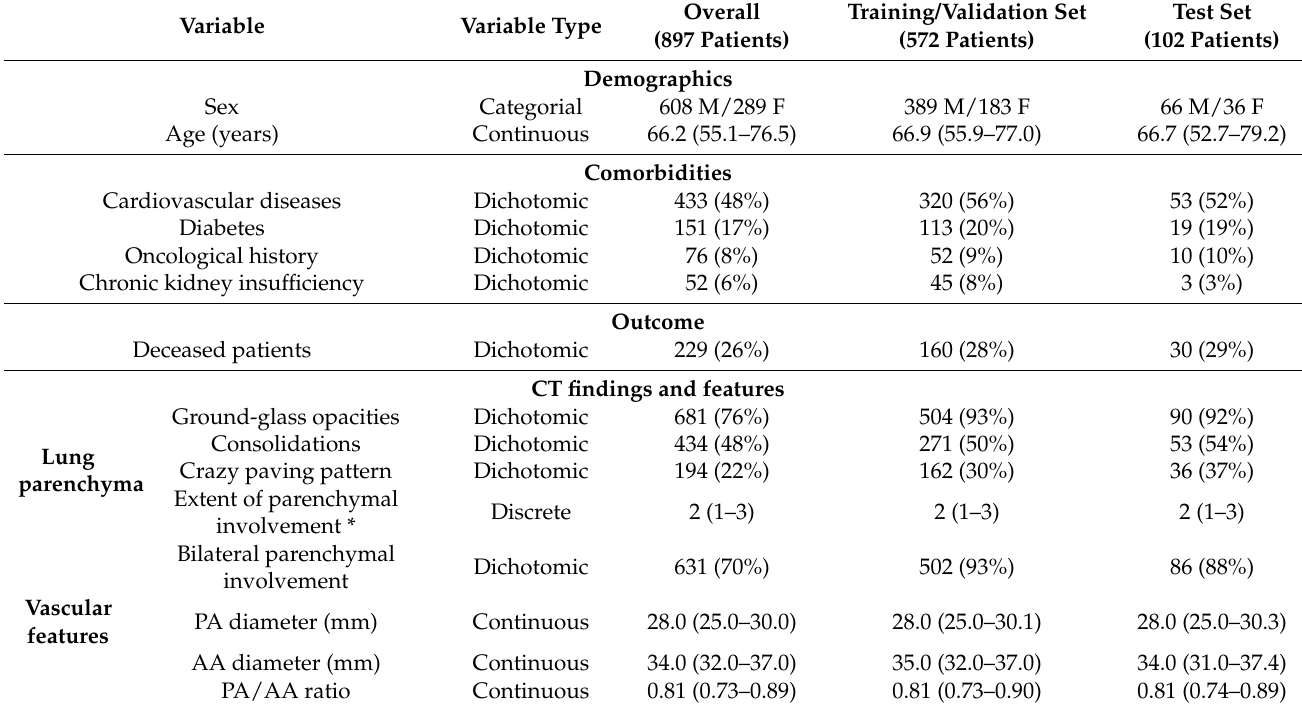
Table 3. Demographic, clinical, and imaging characteristics of the two sets of